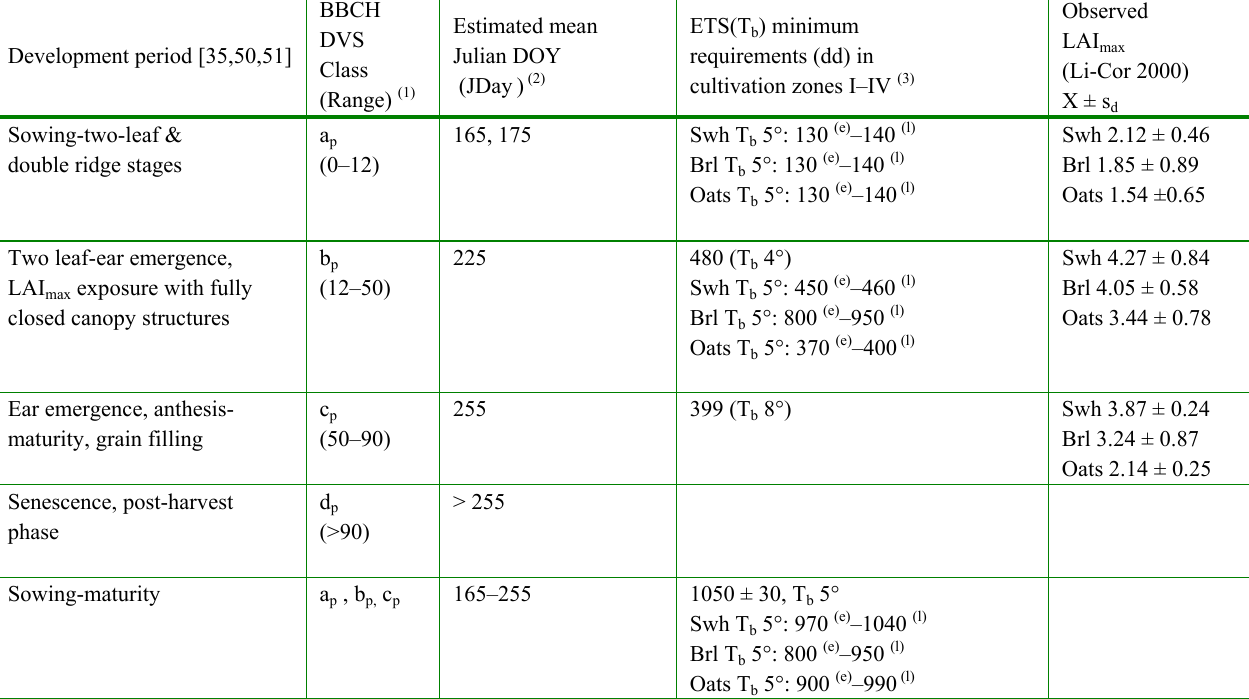
Table 2. SatPhenClass Effective classifiers: Effective temperature sum (ETS) and LAI values for high latitude cereals on growing zones I–IV